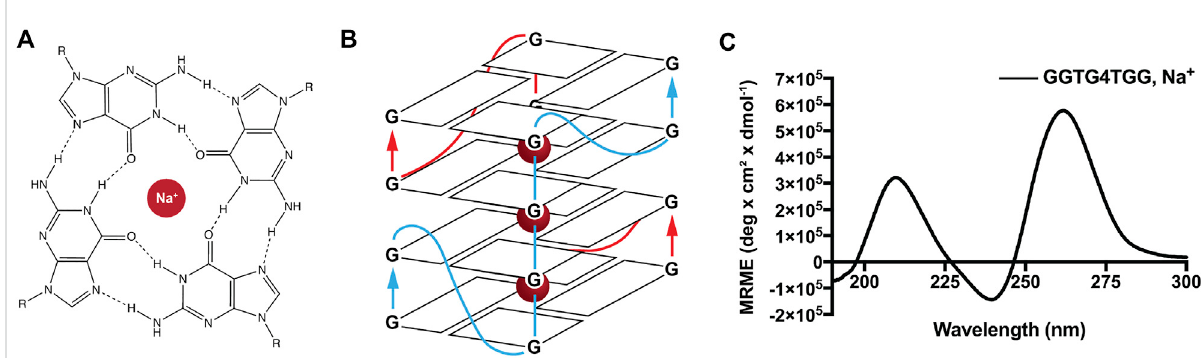
FIGURE 6 Ions like Na+ are conducive to guanine quadruplex formation. Metal cations, including K+ and Na+, facilitate guanine quartet formation through coordination with O6 atoms that project into the internal cavity (A) . Metal cations are arranged equidistant from guanine quartets in the quadruplex, aligning the eight oxygen atoms in a symmetric tetragonal bipyramidal con fi guration. The sequence GGTG4TGG used in this study requires two DNAstrands to associate for proper quadruplex folding and gives the depictedparallel guanine quadruplex (B) . CD ofGGTG4TGG in the presence of Na+ gives the expected parallel quadruplex signature with a maximum positive ellipticity at 260 nm (C)